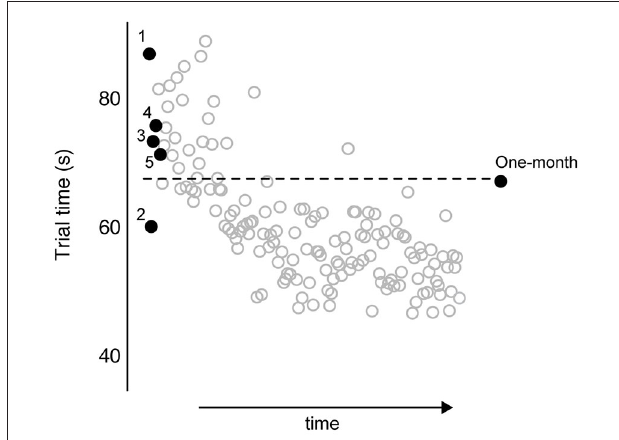
FIGURE 3 | All trial times are plotted for a representative participant . Trial times for training trials 1–5, and at 1 month follow-up, are labeled as such and depicted as • . All remaining trials from skill training are depicted as ◦ . Numeric value of horizontal dashed line ( y = 63.74) was computed from exponential decay curve fitted to first five trials.